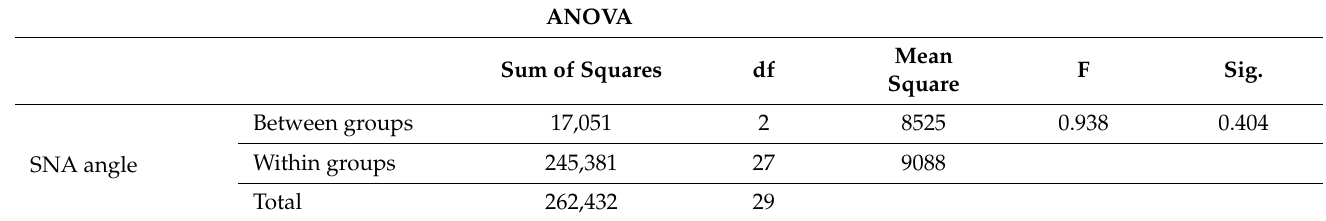
Table 3. ANOVA of cephalometric variables in three OSA severity groups (1 = mild OSA; 2 = moderate OSA; 3 = severe